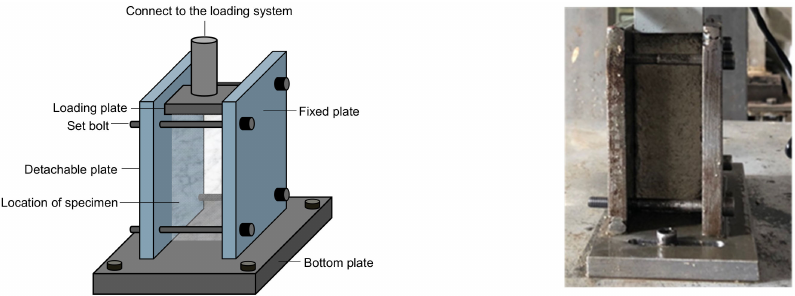
Figure 1. The device to achieve the plane strain condition during the compression